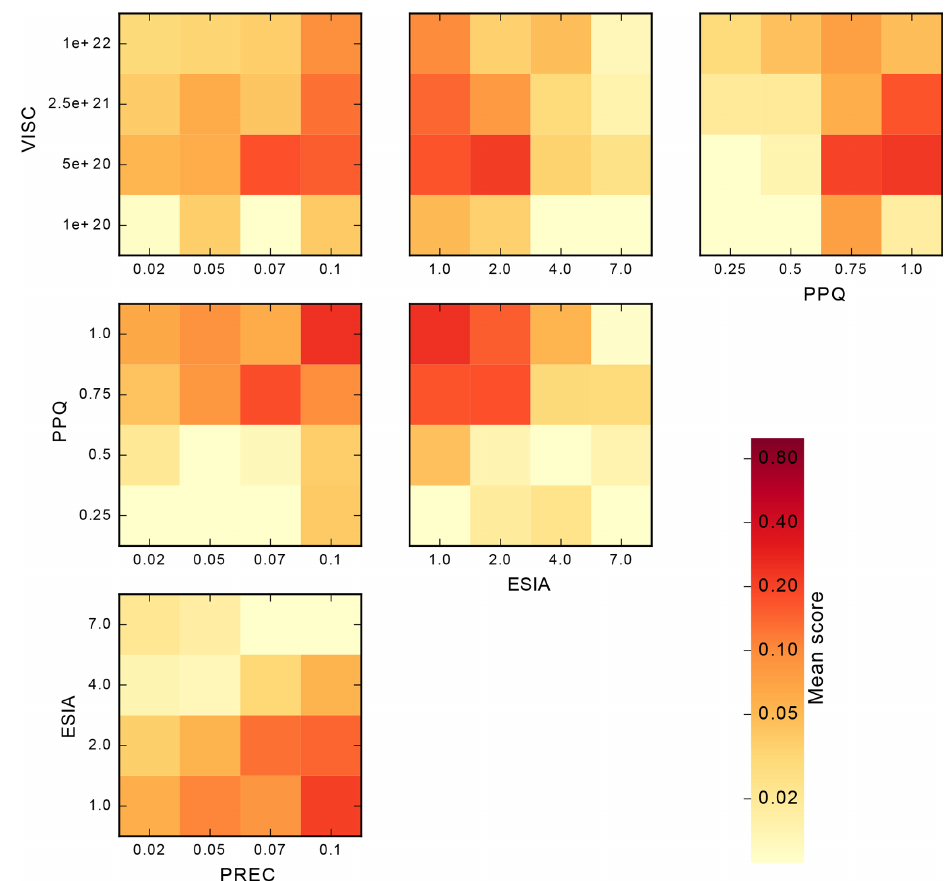
Figure 4. Ensemble-mean scores for six possible pairs of parameter values to visualize parameter dependency (compare Figs. 4 and C3 in Pollard et al., 2016). Values are normalized such that the sum for each pair is 1. Color scale is logarithmic, ranging from 0.01 (bright yellow) to 1